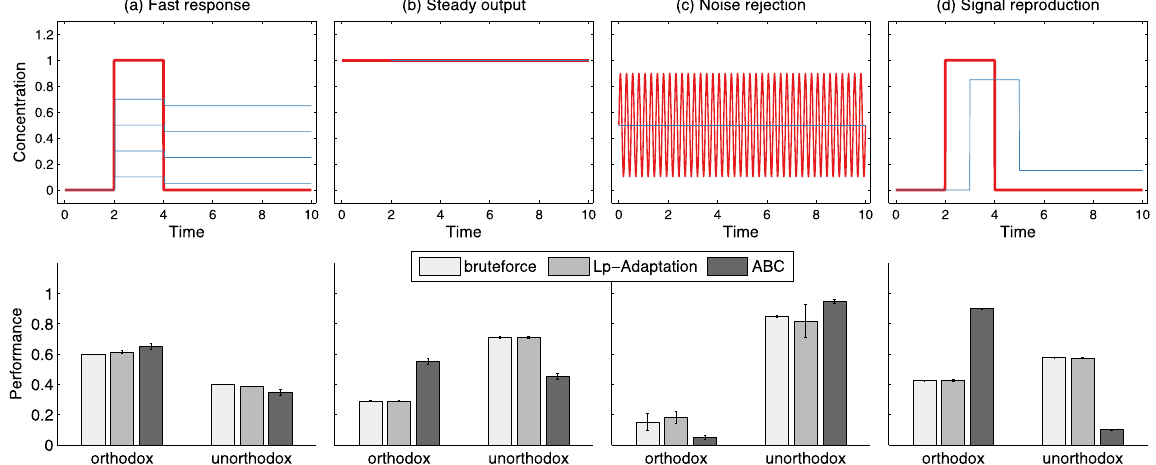
Figure 8. Design centering for four different desired input-output behaviors of the two TCS. Top row: Chemical concentrations as a function of time for the input signal S (red line) and the output signal RR (blue line). For each case, one or several example outputs are shown that fulfill the specifications. Bottom row: The corresponding performances of the orthodox and unorthodox TCS as estimated by three different methods: brute-force sampling, L p -Adaptation, and approximate Bayesian computation based on sequential Monte Carlo (ABC) 2 . Performance is quantified by the posterior probability for each model (ABC) or by the normalized volume ( L p -Adaptation and brute-force) 23 . The error bars are computed as described in the main text. ( a ) The “fast response” case requires the network output to react to sudden changes in the input with no more than 0.1 time units delay. ( b ) The “steady output” case requires the output to remain constant at the level of the input at most 2 time units after the input started. ( c ) The “noise rejection” case requires the output to remain constant at the mean of a rapidly fluctuating input. ( d ) The “signal reproduction” case requires the output to reproduce the shape of the input signal with no more than 20% magnitude error and no more than 1 time unit delay.